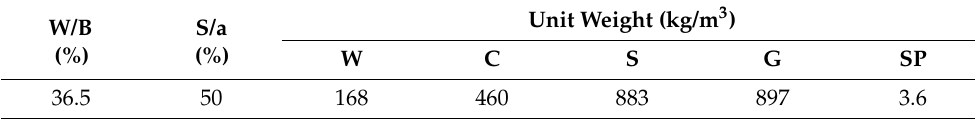
Table 2. Mix proportions of the concrete.